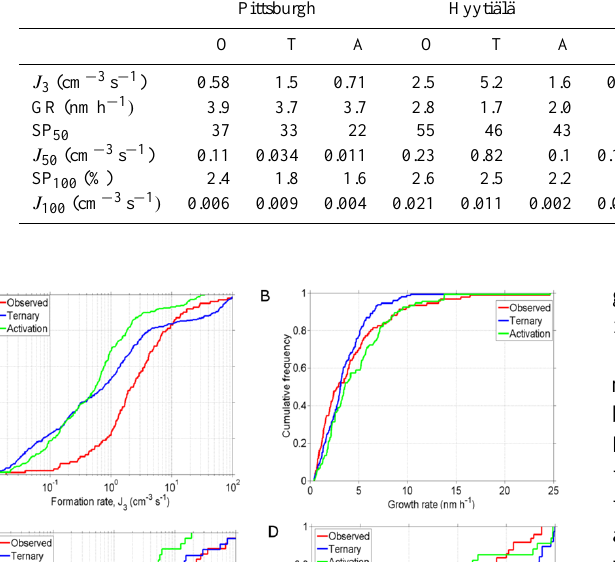
Table 3. Mean values for each metric for each site. O = observed, T = ternary simulation, A = activation simulation. Pittsburgh Hyyti¨al¨a Atlanta St. Louis Po Valley